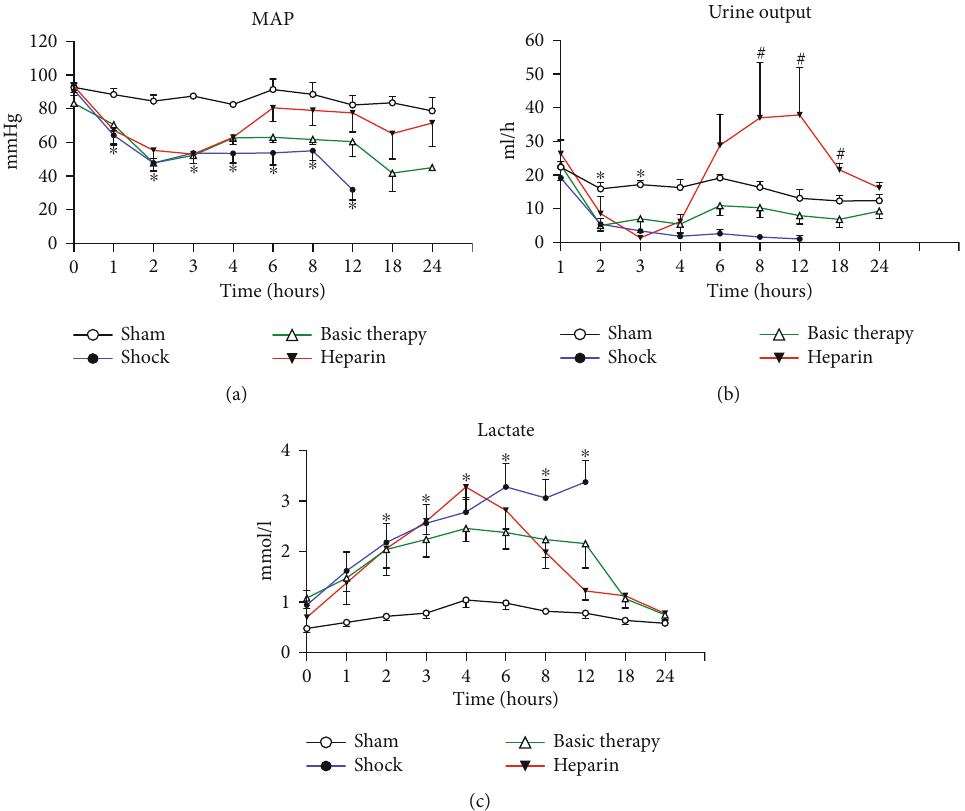
Figure 4: The dynamic characterization of basic physiology index in septic shock. MAP, UO, and the blood lactate level were compared along time among the four groups. ∗ P < 0 : 05 : shock group vs. sham group; # P < 0 : 05 : heparin group vs. basic therapy